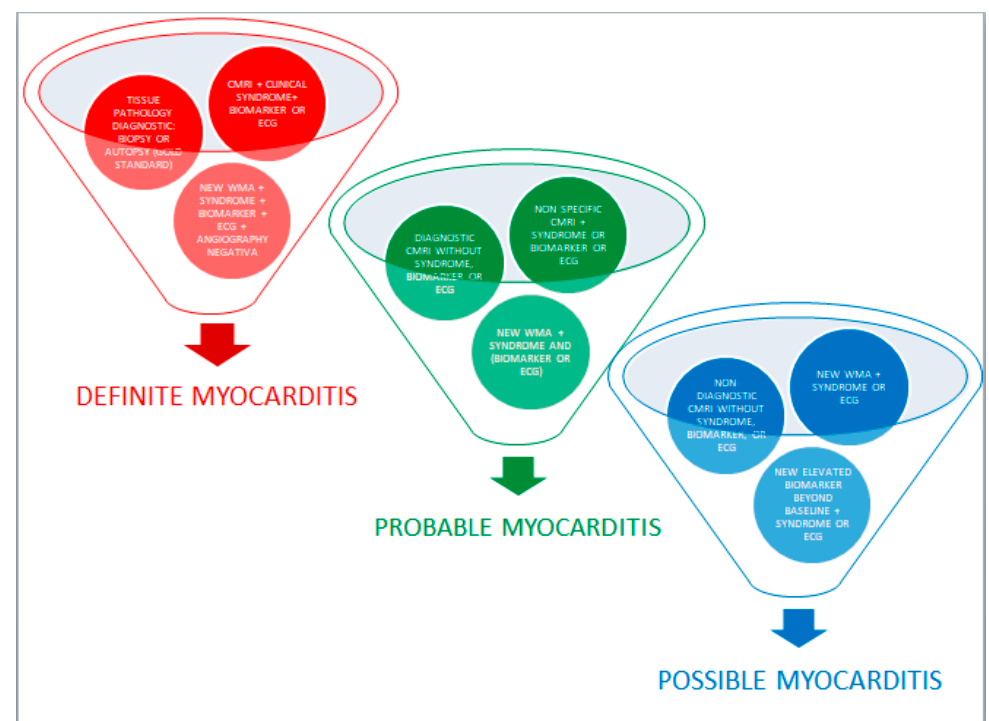
Figure 1. Division of ICI-related myocarditis cases into three groups: definite myocarditis, probable myocarditis, and possible myocarditis.